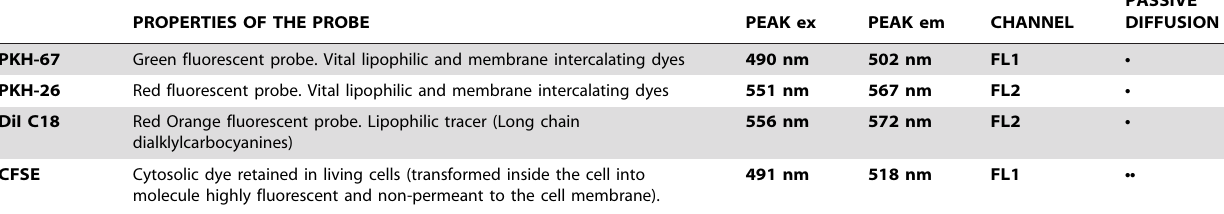
Table 1. Evaluation of passive